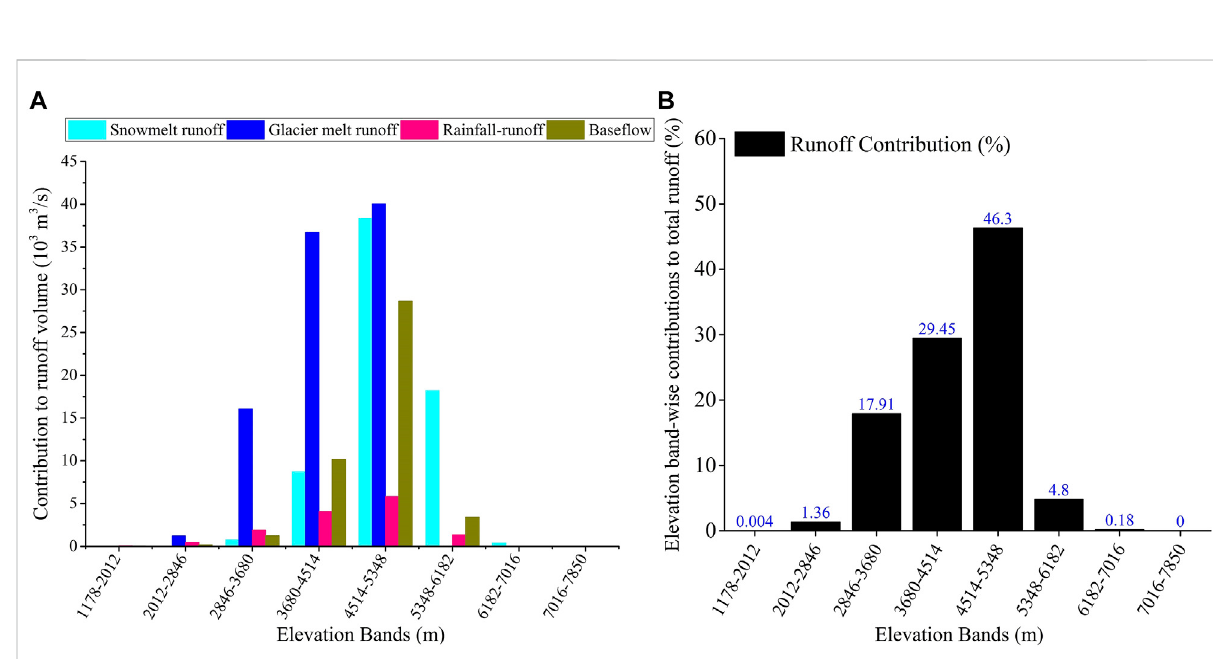
FIGURE 12 Relative contribution of, (A) runoff components and, (B) runoff to stream fl ows from different